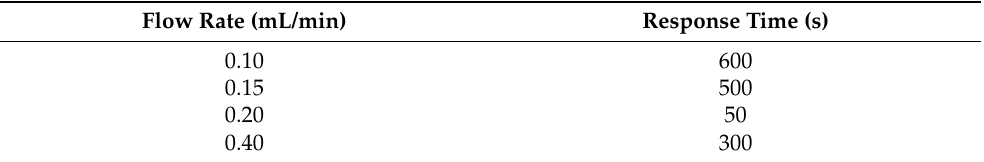
Table 6. Response time in respect of the flow rate for lithium detection ([Li + ] = 0.01 M) with the microflow setup.